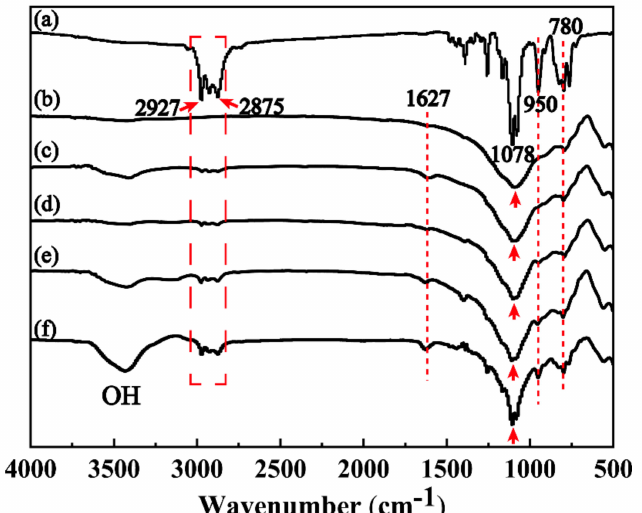
Figure 4. Infrared spectra of coupling agents of GPTMS, unmodified MFA and MFA modified by di ff erent contents of GPTMS: ( a ) GPTMS; ( b ) unmodified MFA; ( c ) MFA modified by 0.5 wt. % GPTMS; ( d ) MFA modified by 1.5 wt. % GPTMS; and ( e ) MFA modified by 2.5 wt. % GPTMS; ( f ) MFA modified by 3.5 wt. %